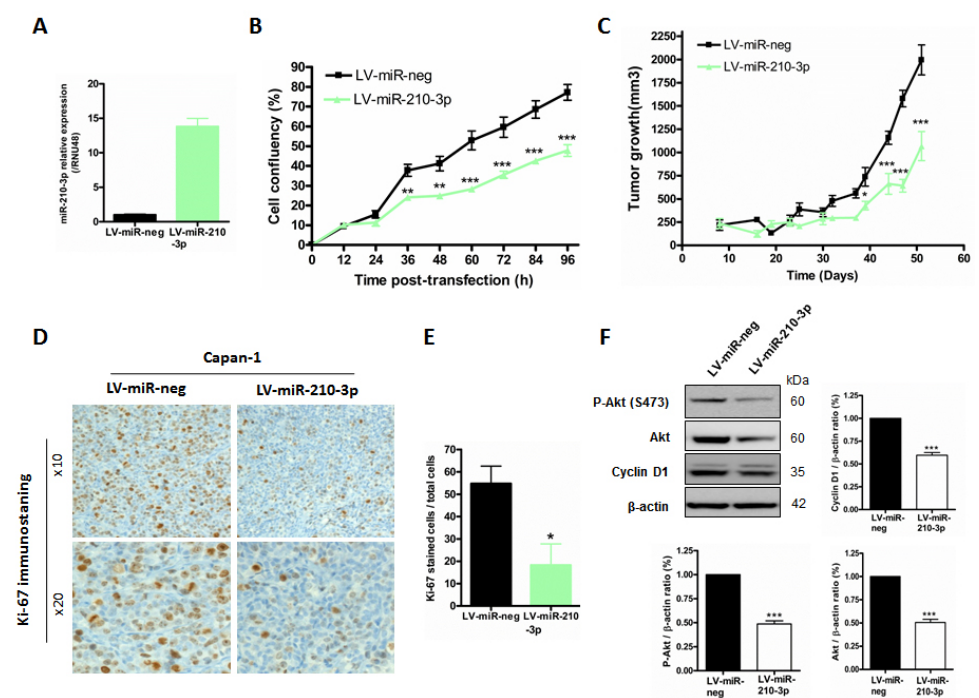
Figure 7. MiR-210-3p inhibits pancreatic tumor growth in vivo. ( A ) RT-qPCR analysis of miR-210-3p relative expression in Capan-1 LV-miR-210 and Capan-1 LV-miR-neg control cells. MiR-210-3p expression is evaluated according to the 2 − ∆∆ Ct method ( ∆∆ Ct = (Ct miR-210—Ct RNU48)—Ct miR-neg). MiR-210-3p expression in Capan-1 LV-miR-neg control cells was arbitrarily set to 1. ( B ) Proliferation of Capan-1 LV-miR-210 cells compared with their controls, LV-miR-neg (** p < 0.01 or *** p < 0.001). Three independent experiments were performed. ( C ) Subcutaneous xenografts of Capan-1 LV-miR-210-3p and Capan-1 LV-miR-neg control cells in SCID mice. Tumor growth (mm 3 ) was evaluated until mice were euthanized. * p < 0.05 and *** p < 0.001 indicate statistical significance of miR-210-3p compared with miR-neg control. ( D ) Ki-67 immuno-histochemical staining was performed on xenografted tumors. Original magnification: × 10 (upper panel) and × 20 (lower panel). ( E ) Ki-67 + percentage was calculated and represented as histograms. * p < 0.05 indicates statistical significance of miR-210-3p compared to miR-neg control. ( F ) Western blot analysis of S474 phospho-Akt, Akt, Cyclin D1 and β -actin protein expression in Capan-1 LV-miR-210-3p and Capan-1 LV-miR-neg control cells. Akt/ β -actin, pAKT/ β -actin, and Cyclin D1/ β -actin ratios are indicated on the respective histograms. Three independent experiments were performed. *** p < 0.001 indicates statistical significance compared to Capan-1 LV-miR-neg control